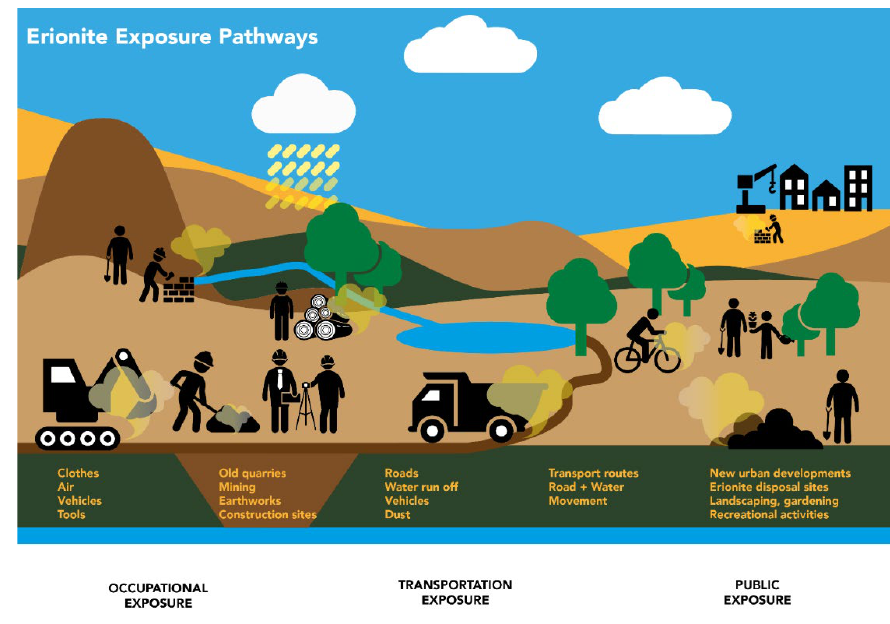
Figure 4. A summary of potential exposure pathways for erionite and other EMPs.